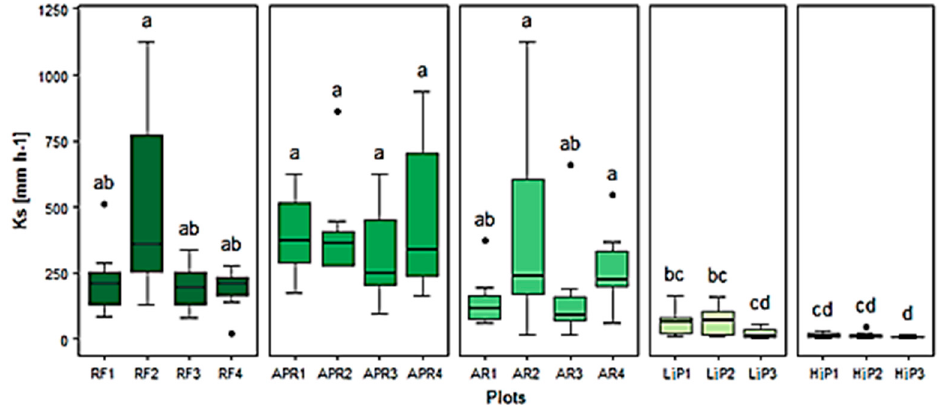
Figure 4. K s at the surface by individual plots. Different letters above boxplots indicate significant difference based on Tukey’s test ( p < 0.05). RF, Reference Forest; APR, Assisted Passive Restoration; AR, Active Restoration; LiP, Low-intensity Pasture; HiP, High-intensity Pasture. The subscript number refer to plot numbers.